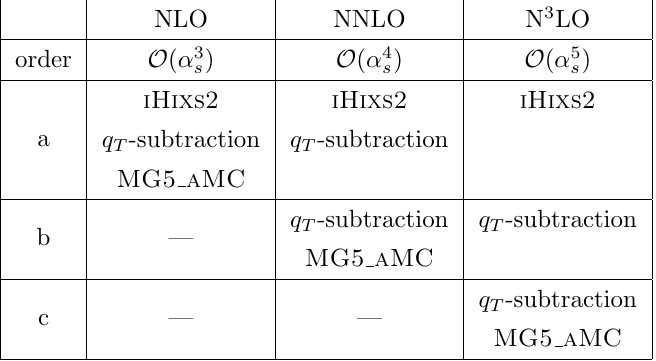
Table 2 . A summary of independent calculations we have performed at di(cid:11)erent orders and for di(cid:11)erent